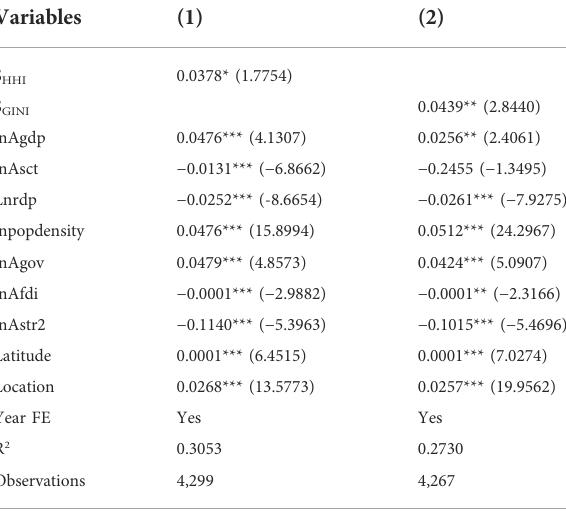
TABLE 7 Robustness check substituting GINI and HHI for the explanatory